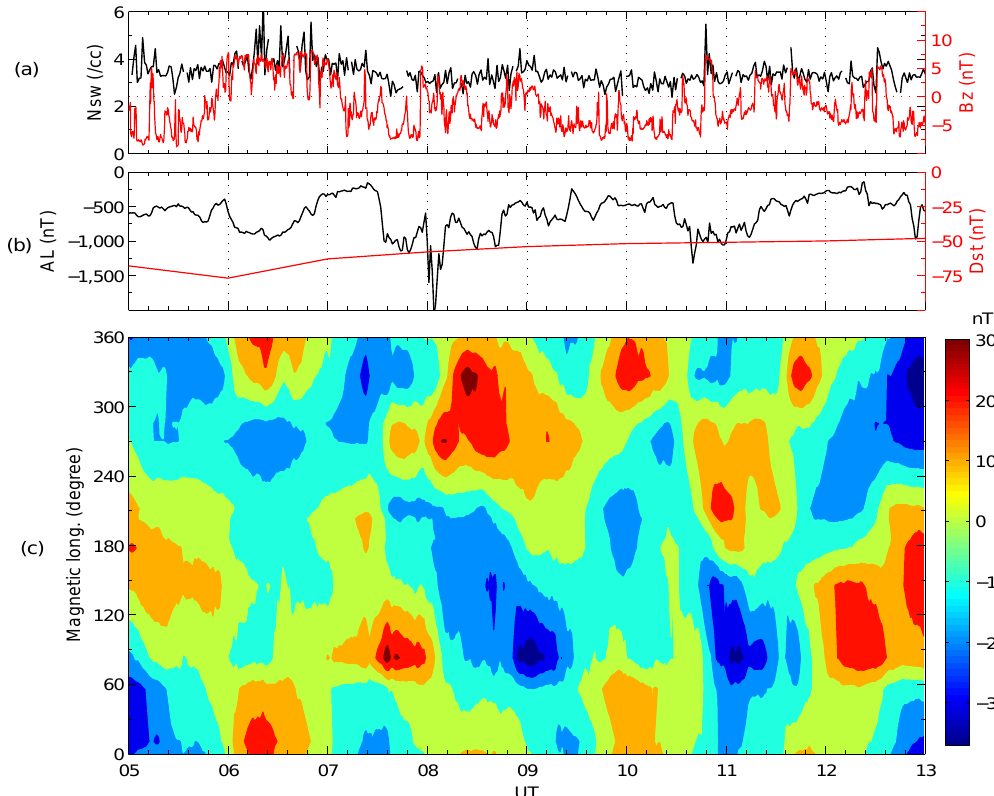
Fig. 3. Solar wind density ( N sw ) and IMF B z fluctuations and ground magnetic disturbance on 15 October 2003. (a) IMF B z (shown in red) fluctuates between ± 10nT, whereas N sw (black line) is relatively steady during the event. (b) Hourly Dst index (red) shows a moderate storm was in progress and various intense substorm were triggered as indicated by AL index shown in black. (c) Contour plot of 1H asym indicates disturbance propagating westward in